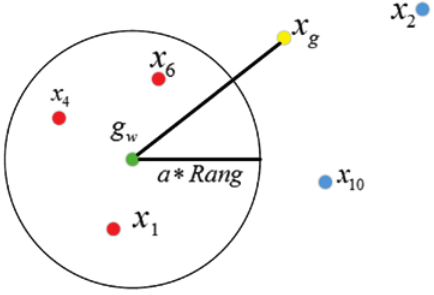
Figure 1: The Neighborhood of g